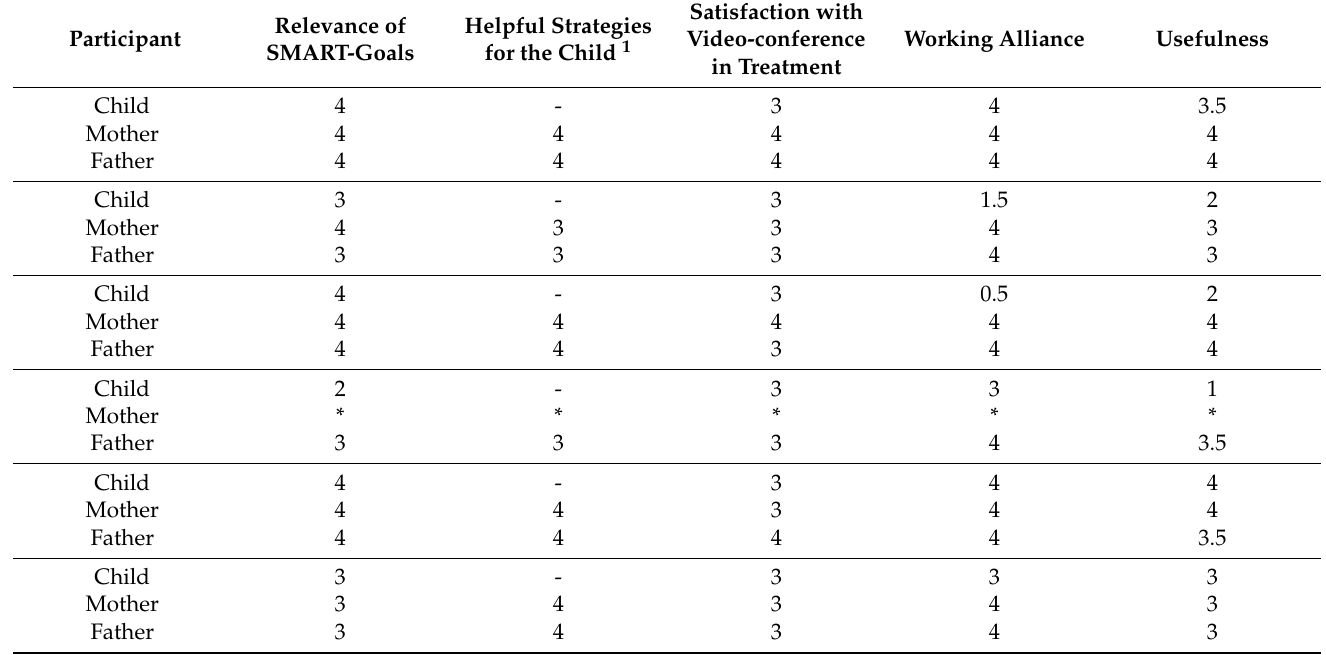
Table 4. Working alliance, usefulness and evaluation of SMART-goals and strategies, scale from 0 (“Completely disagree”) to 4 (“Completely agree”).